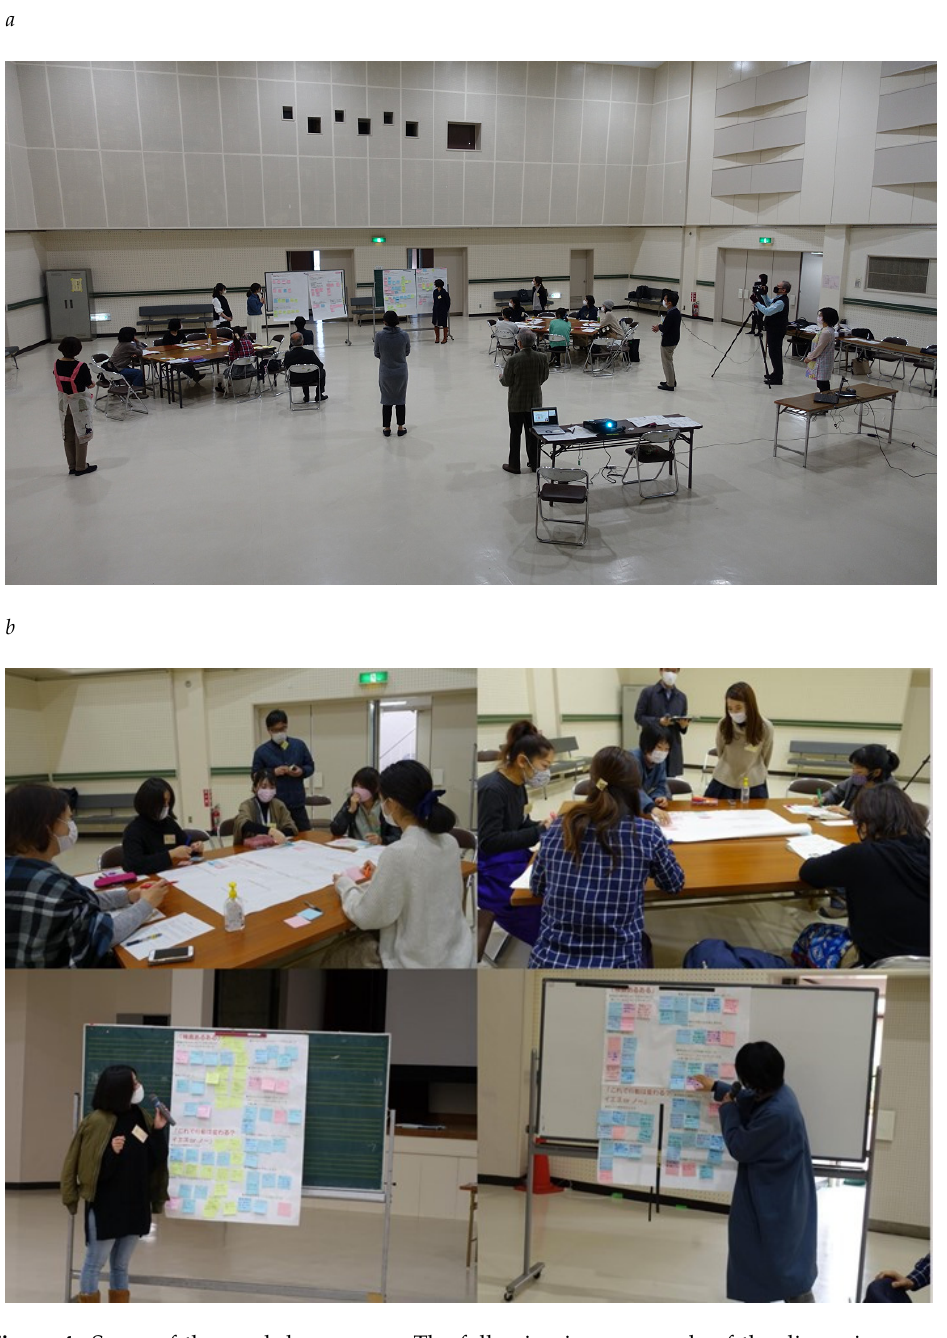
Figure 4. Scene of the workshop venue. The following is an example of the discussion process. ( a ), General view of the 8th workshop. ( b ), The discussion process during the 7th workshop. Participants were divided into two groups (left and right) and desk-based discussions (top) and board-based presentations (bottom) were conducted.